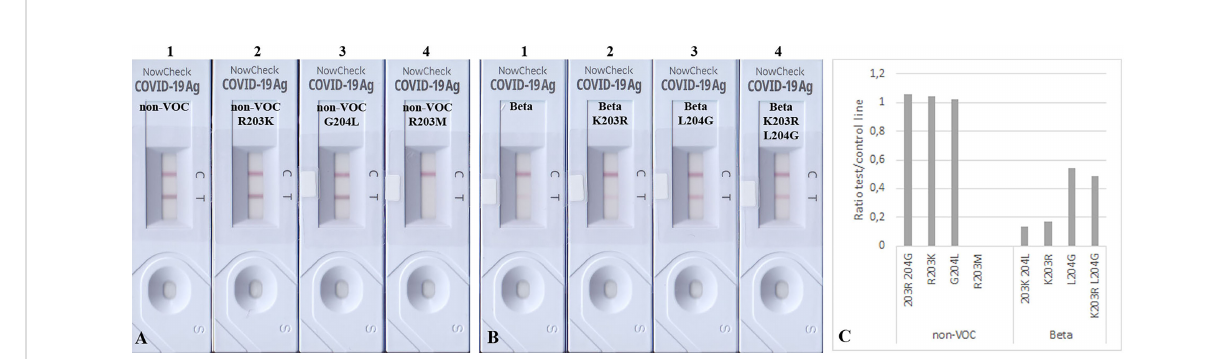
FIGURE 4 Detection of 100 ng mutated N proteins by RATs from BioNote. Numbers label speci fi c RATs in (A) and (B) for easier orientation. Changes at positions 203 (A2) and 204 (A3) of the non-VOC N protein to the amino acids found in VOC Beta at these positions do not alter the detection of the N protein by the BioNote RAT as seen by densitometric analysis (C) . In contrast, R203M mutation (A4) impairs the detection ultimately. Whereas the K203R mutation (B2) in the Beta N protein does not alter the test line intensity, the L204G (B3, alone and B4 in combination with K203R) mutation enhanced the detection of Beta compared to Beta